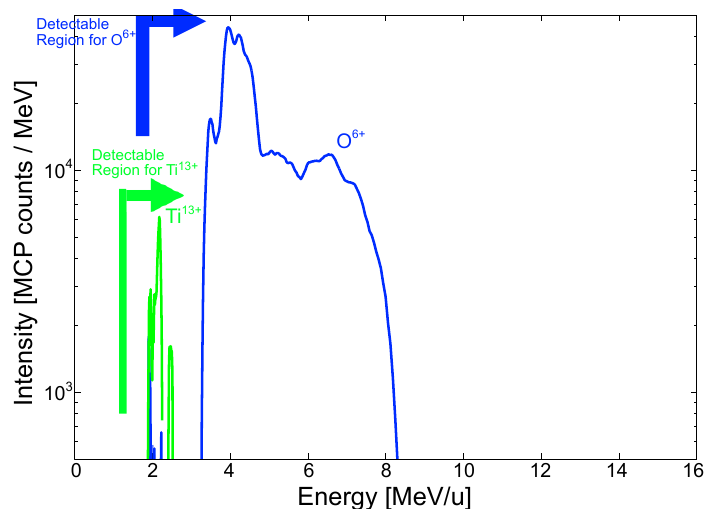
Figure 7. The Ti 13+ and O 6+ spectra with CW laser heating. The enhanced acceleration of O 6+ spectrum Figure 7. The Ti 13 + and O 6 + spectra with CW laser heating. The enhanced acceleration of O 6 + spectrum shows a non-thermal-like distribution. shows a non-thermal-like